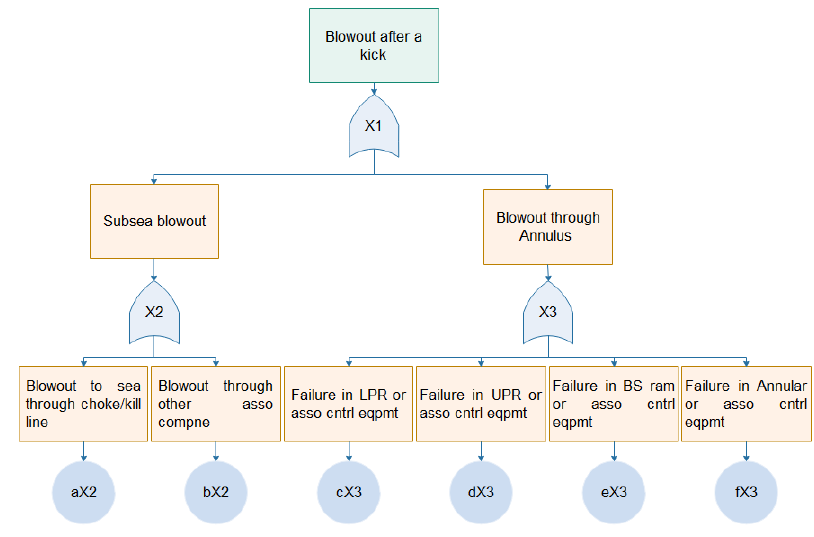
Figure 3. Top level of fault tree. Table 3. Weights and rankings of some BOP